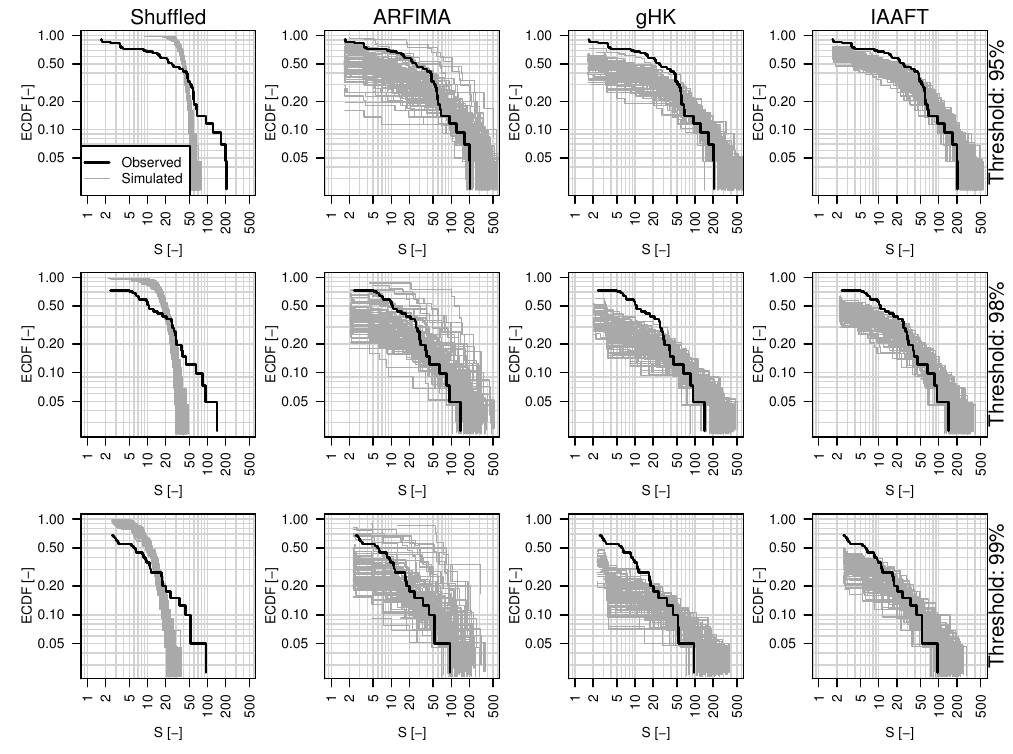
Figure 16. Illustrative ECDFs of S for observed and simulated data referring to the Escotais River. Grey lines denote an ensemble of 100 curves resulting from time series